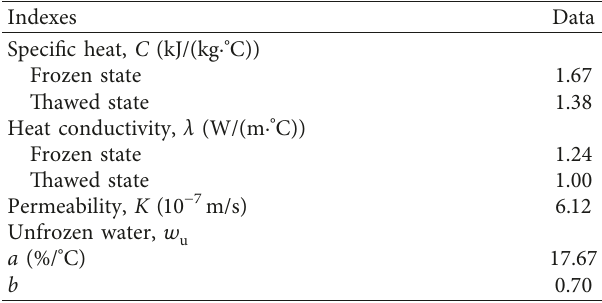
Table 4: Characteristic indexes for heat and water migration for loess.